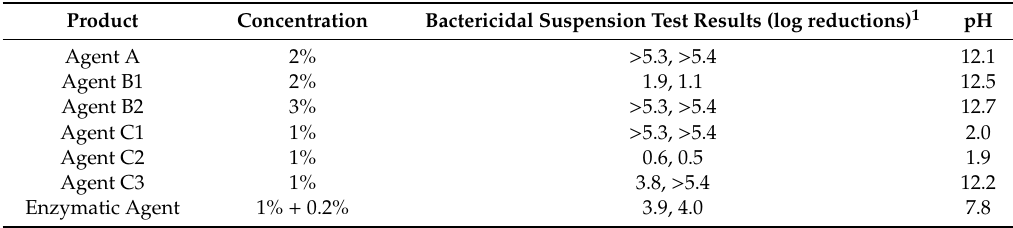
Table 2. Bactericidal suspension test results (cleaning